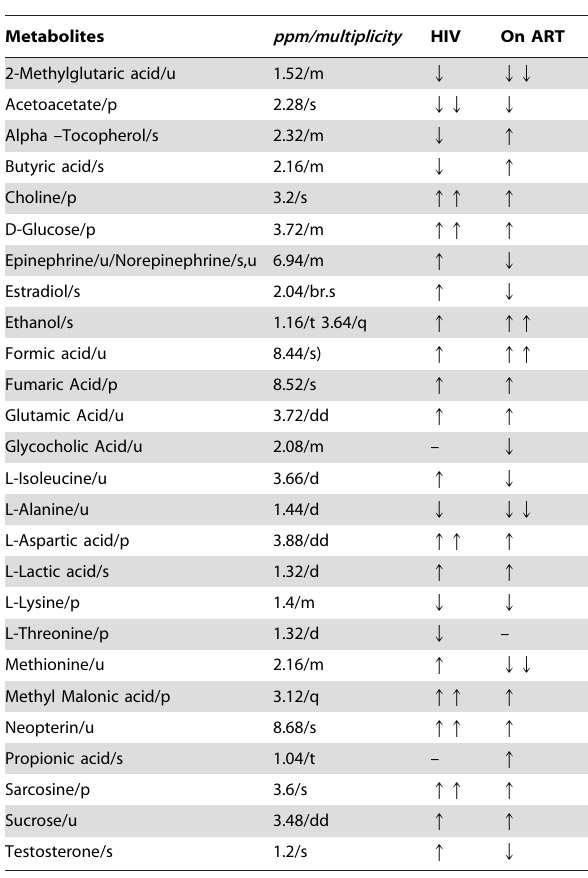
The metabolites differentially regulated in plasma (p), urine (u) or saliva (s) in HIV/AIDS patients and patients on ART are shown. The arrows indicate lower ( Q ) or higher ( q ) arbitrary levels of metabolites compared to healthy controls.